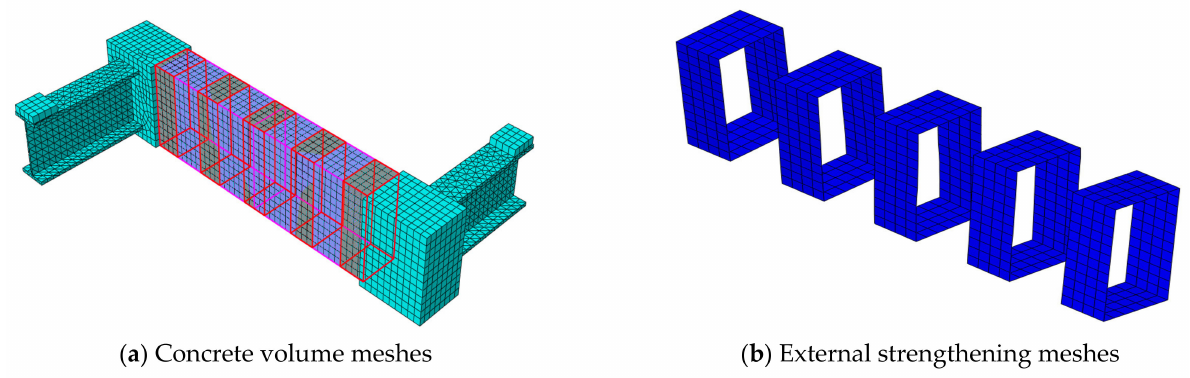
Figure 26. Meshes of beam B1-AS (2).